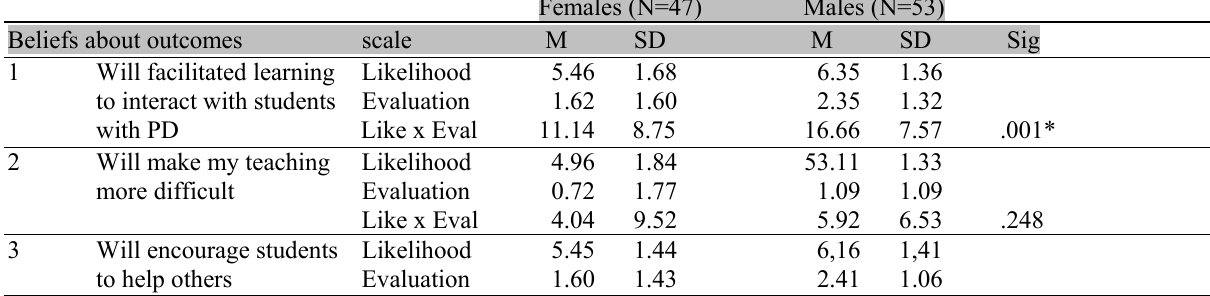
Table 1. Scores of female and male in-service PE teachers on Behavioral Beliefs Females (N=47) Males (N=53) Beliefs about outcomes scale M SD